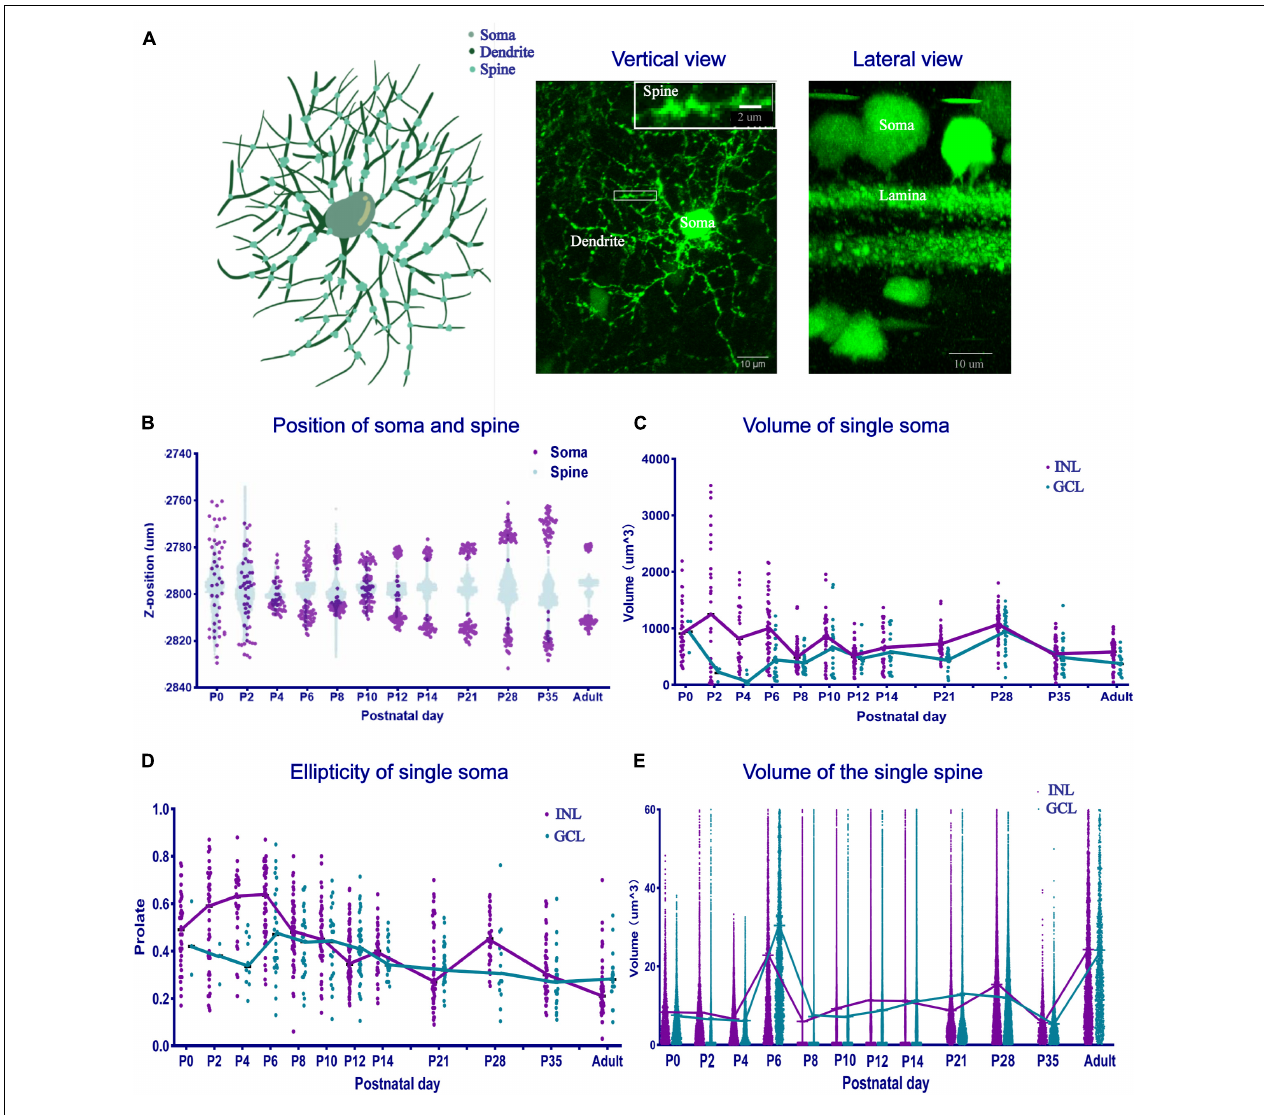
FIGURE 6 | The position, volume, and morphology of single-cell soma and spines changed. (A) The schematic and fluorographs show the distinction of soma, dendrites, and spines. The white box shows an enlarged image area. Bar = 10 µ m in the vertical and lateral view. Bar = 2 µ m in the enlarged image. (B) Single-cell soma and spine position distribution. At P0 and P2, both the soma and spines were scattered and then gathered into two groups at P4. The distance between the soma layers became large. (C) Single-soma volume development. Single-soma volume showed increased uniformity. The INL volume increased, then decreased, and became stable at the adult level. The GCL volume decreased first, then increased, and became stable at the adult level. (D) Single-soma morphology development. The morphology distribution was always dispersive at different time points. (E) Single-spine volume development. The mean single-spine volume was nearly the same, with two peaks at P6 and in adulthood ( n = 4 for each timepoint in all the panels).